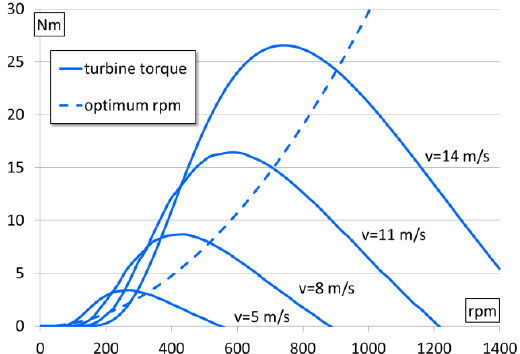
Figure 4. Turbine torque as function of the rotational speed for several wind speeds, and the optimum operation